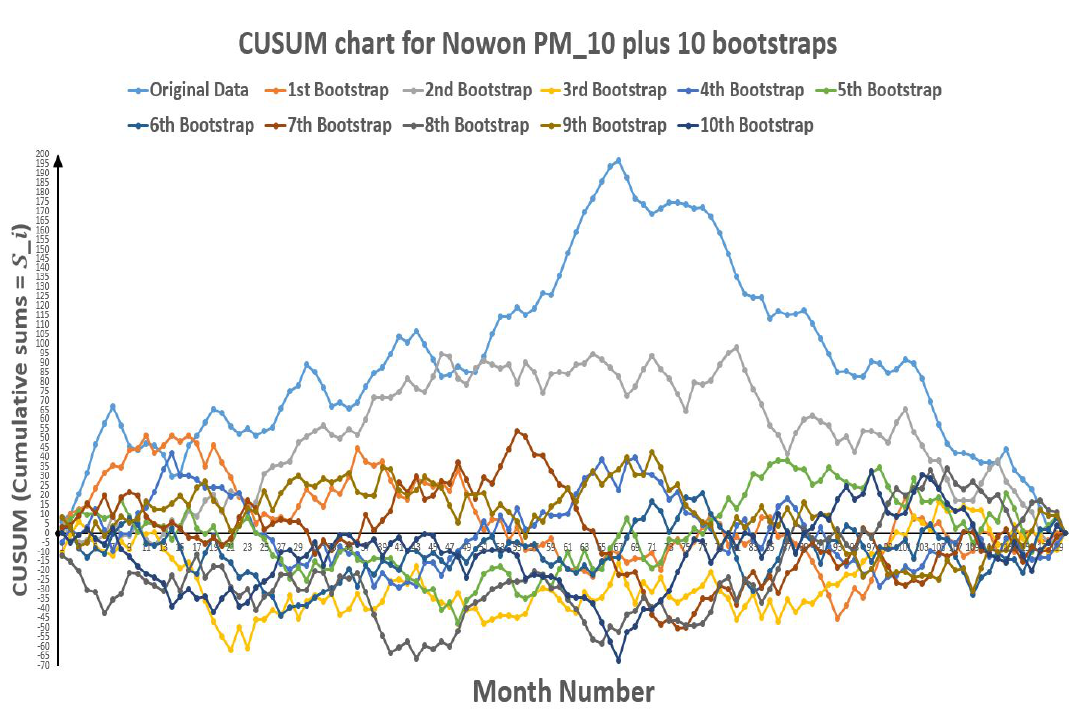
Figure 13. CUSUM chart for Nowon PM 10 plus 10 bootstraps (European